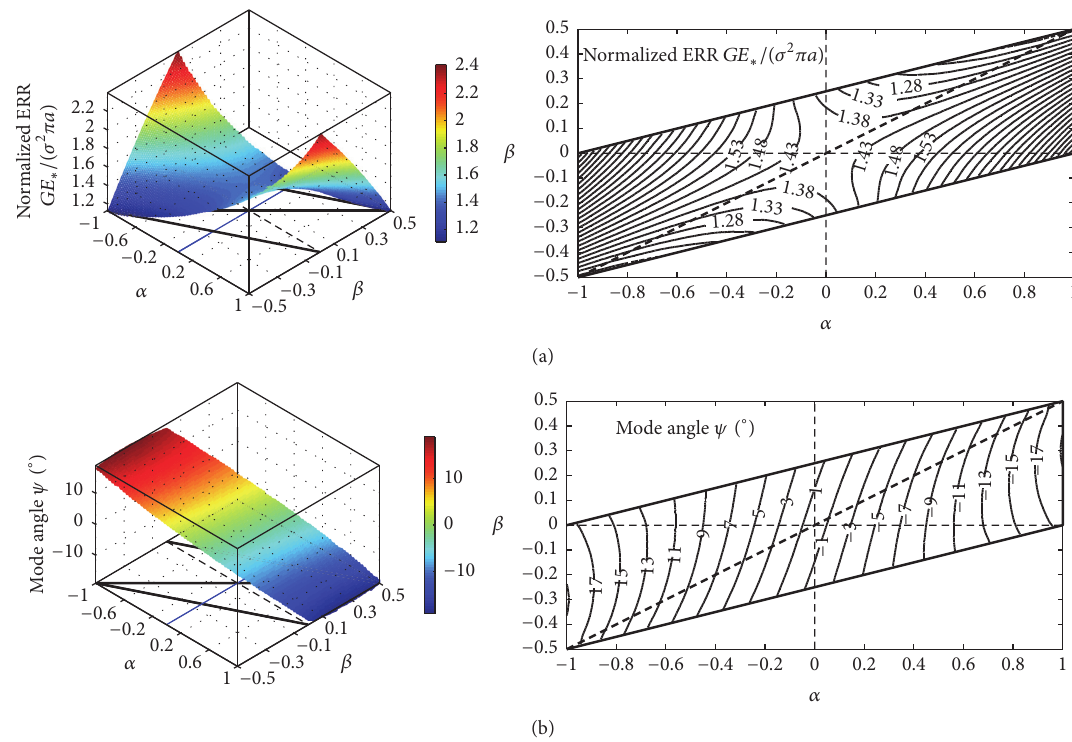
Figure 7: 3D distributions and contour plots of (a) normalized ERR 𝐺𝐸 ∗ /(𝜎 2 𝜋𝑎) and (b) mode angle 𝜓